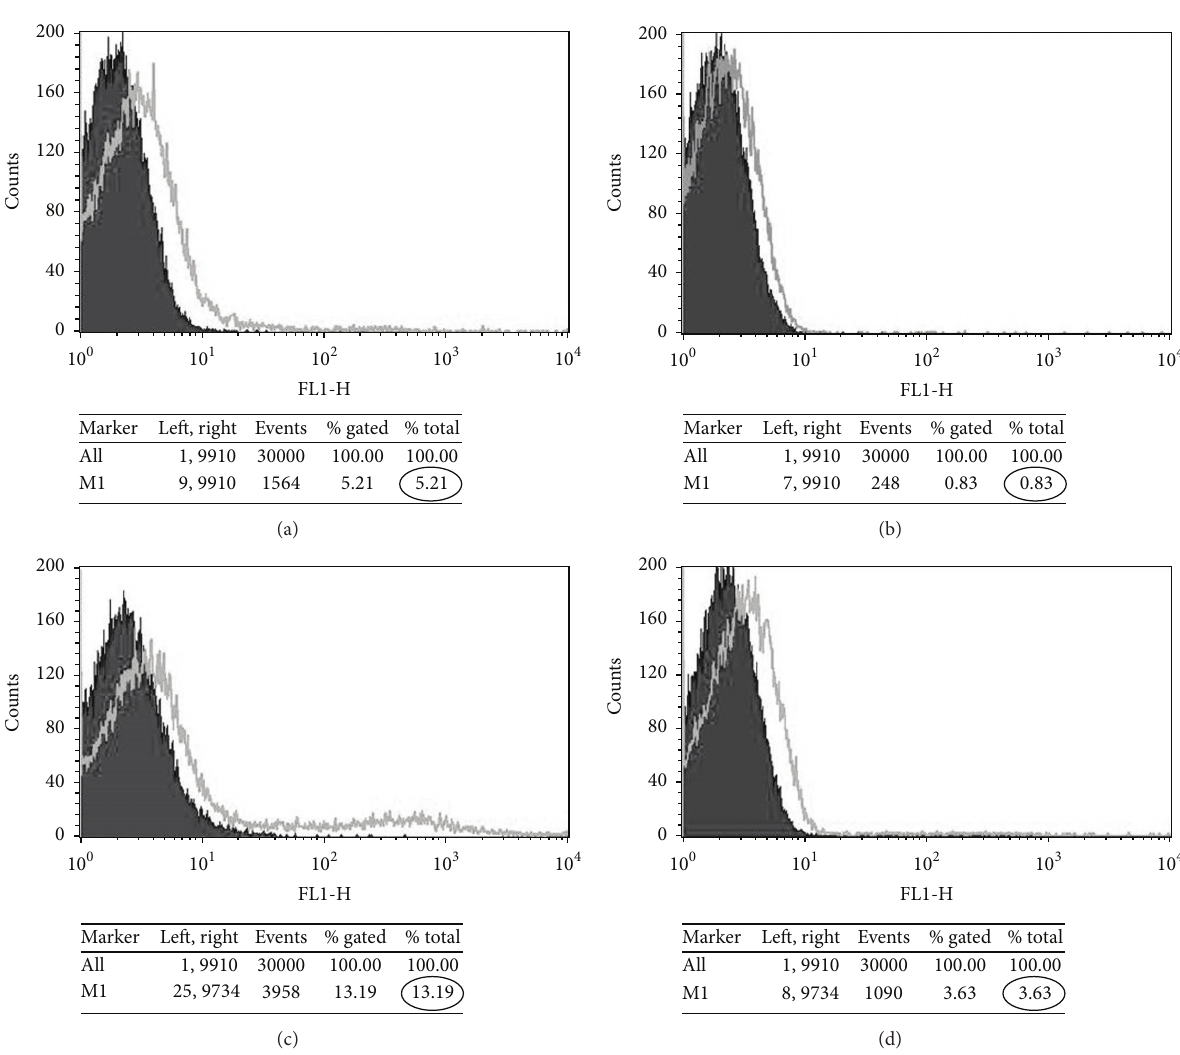
Figure 3: Annexin V-FITC binding of PS in (a) lighter RBC fraction of father, (b) older RBC fraction of father, (c) lighter RBC fraction of son, and (d) older RBC fraction of